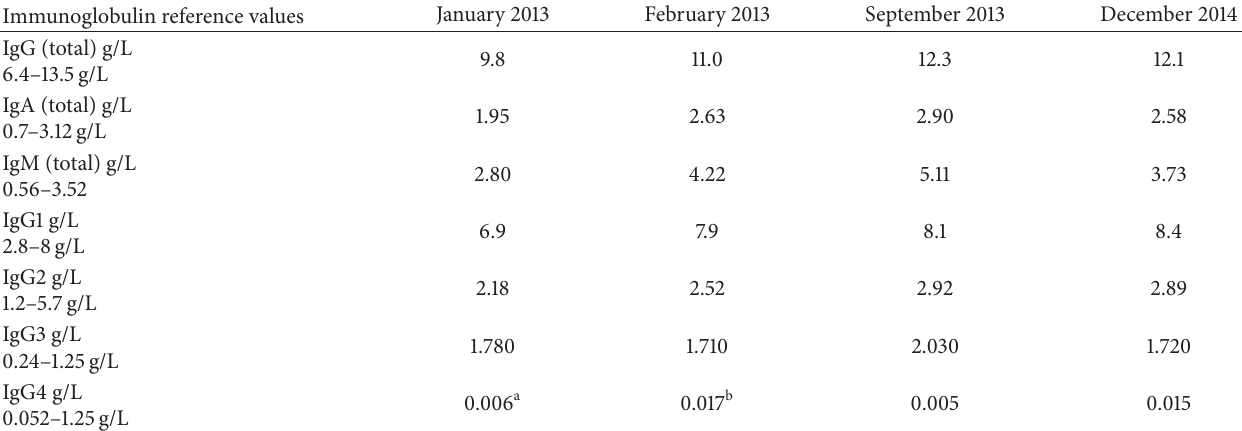
Table 1: Levels of immunoglobulins and